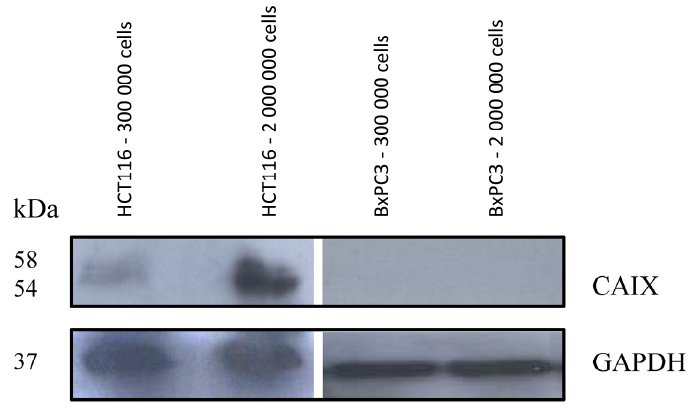
Figure 1. Western Blot analysis of HCT116 and BxPC3 cells at two different cellular densities. GAPDH was used as loading control.